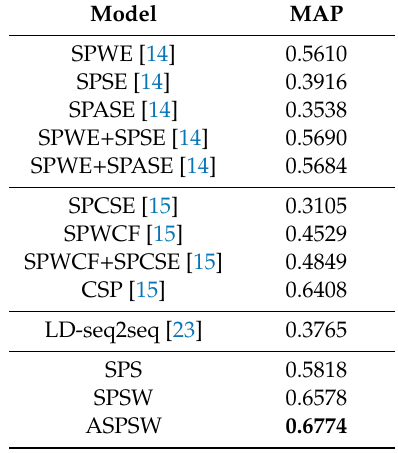
Table 2. Prediction accuracy: Mean Average Precision (MAP); the best result is in bold-faced.